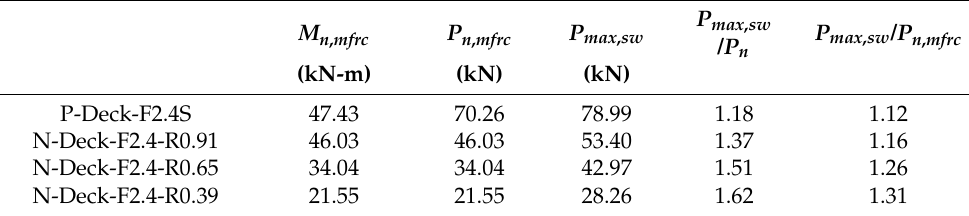
Table 9. Comparison of ultimate flexural strength between the standard [20,29] and the model proposed